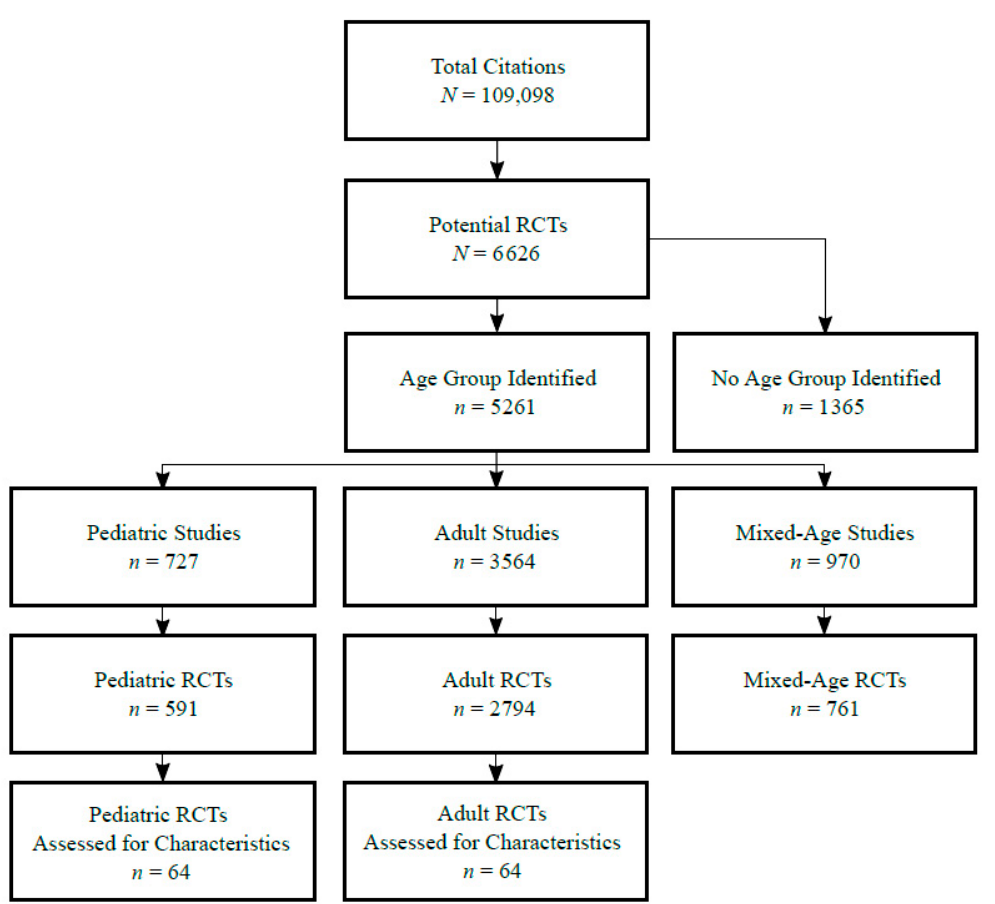
Figure 1. Study selection flow diagram stratified by age group of study. RCTs: randomized controlled trials.